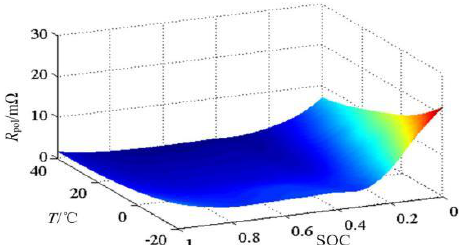
Figure 3. Relationship among the measured R pol , SOC, and T .